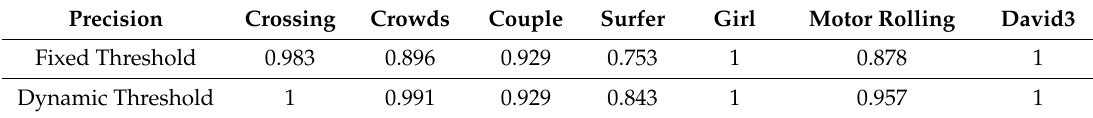
Figure 3. Partial tracking result in Jogging-1 sequence. Table 1. Comparison of fixed threshold and dynamic